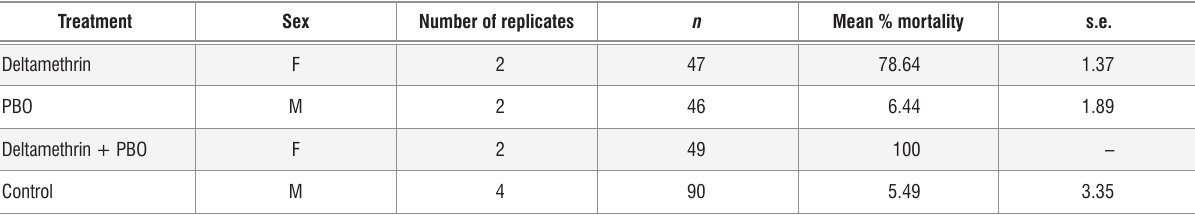
Mean percentage mortalities recorded for samples of 2–6-day-old F1 Anopheles arabiensis male adults (M) or female adults (F) following exposure to either deltamethrin (0.05%), piperonyl butoxide (PBO) (4%), deltamethrin + PBO or untreated control papers. Mortalities were recorded 24 h post exposure. The number of replicates, sample size ( n ) and standard error (s.e.) are given for each treatment. Mortalities following exposure to PBO and control papers were negligible. There is a significant difference in mean mortality between the deltamethrin and deltamethrin + PBO treatments 24 h post exposure (paired sample t- test: d.f.=1, t =15.65, p